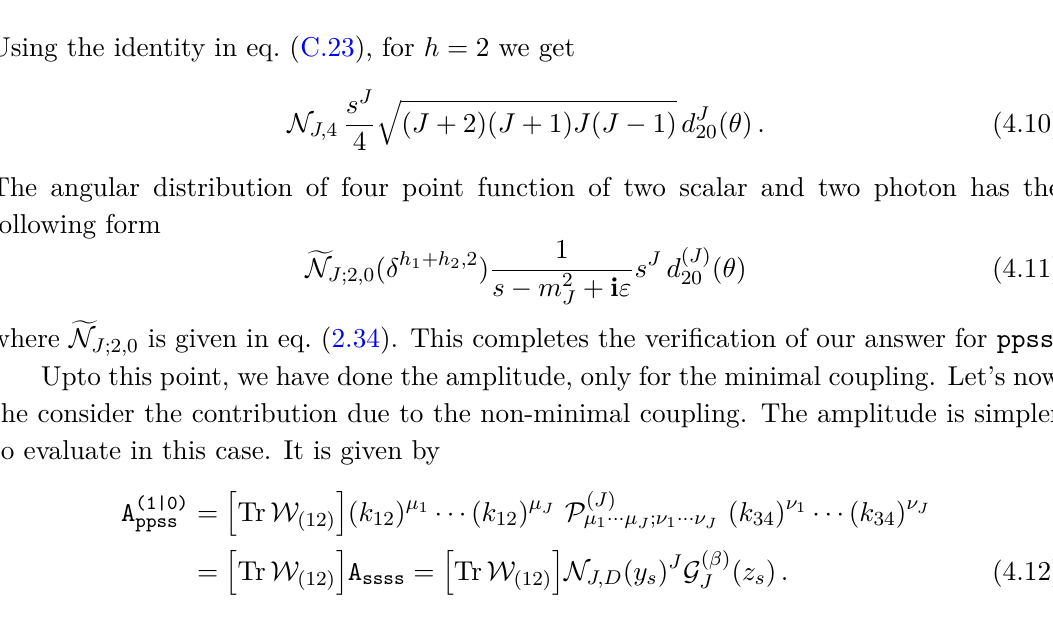
Table 2 . Angular distributions for ppss tensor